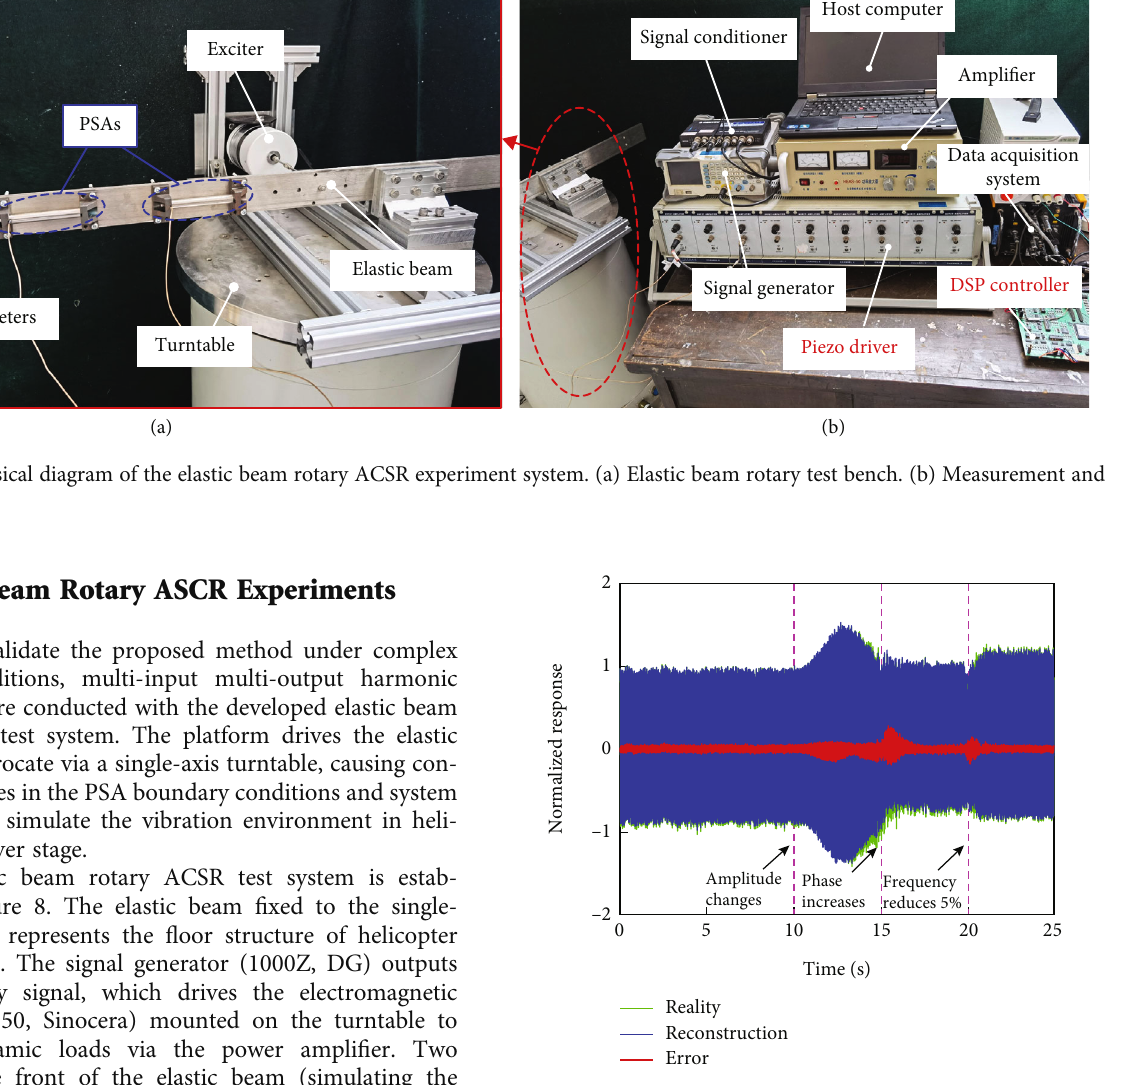
Figure 11: Comparison between the reality and construction